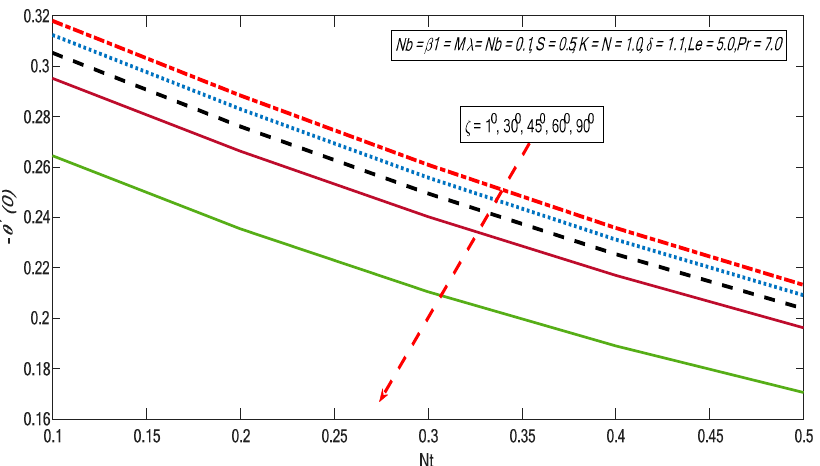
Figure 23. Variations of reduced Nusselt number with 𝑁𝑡 for different values of 𝜁 .